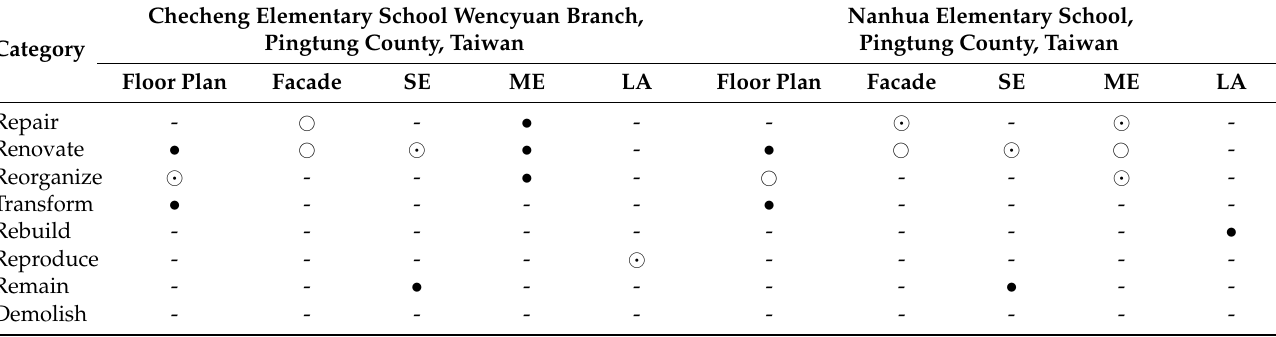
Figure 6. Floor Plans: ( a , b ) Nanhua Elementary School Floor Plans. Table 2. Building Reconfiguration measures and